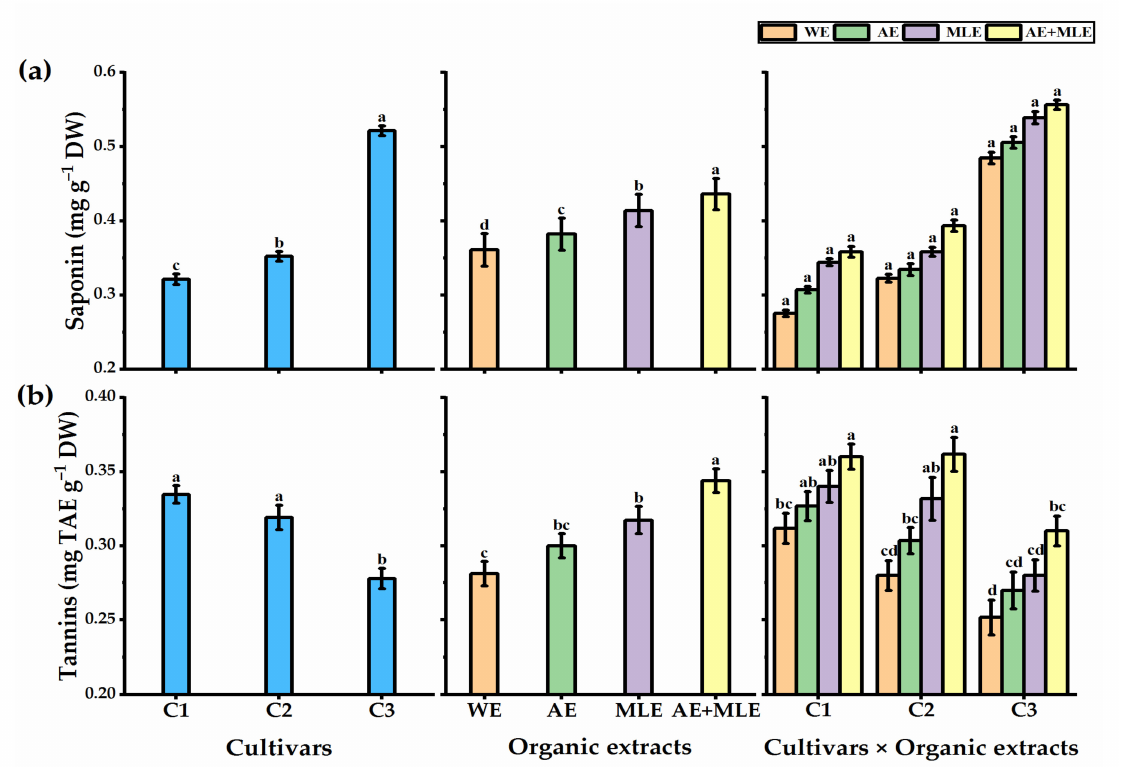
Figure 6. Effect of Azolla extract, moringa leaf extract, and their combination on ( a ) saponin (mg g − 1 DW), and ( b ) tannins (mg TAE g − 1 DW) of three quinoa cultivars. C1 = KVL − SRAZ, C2 = Chipaya, C3 = Q − 37, WE = without extract, AE = Azolla extract, MLE = moringa leaf extract. Data are mean value ± SE, n = 3. Different letters denote significant differences at p ≤ 0.05